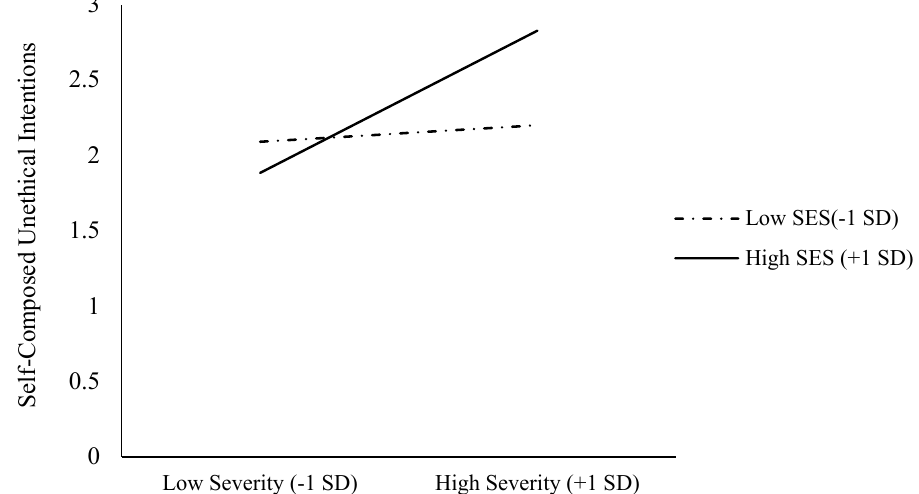
Figure 2. Self-composed unethical intentions as functions of epidemic severity and SES (Study 1).